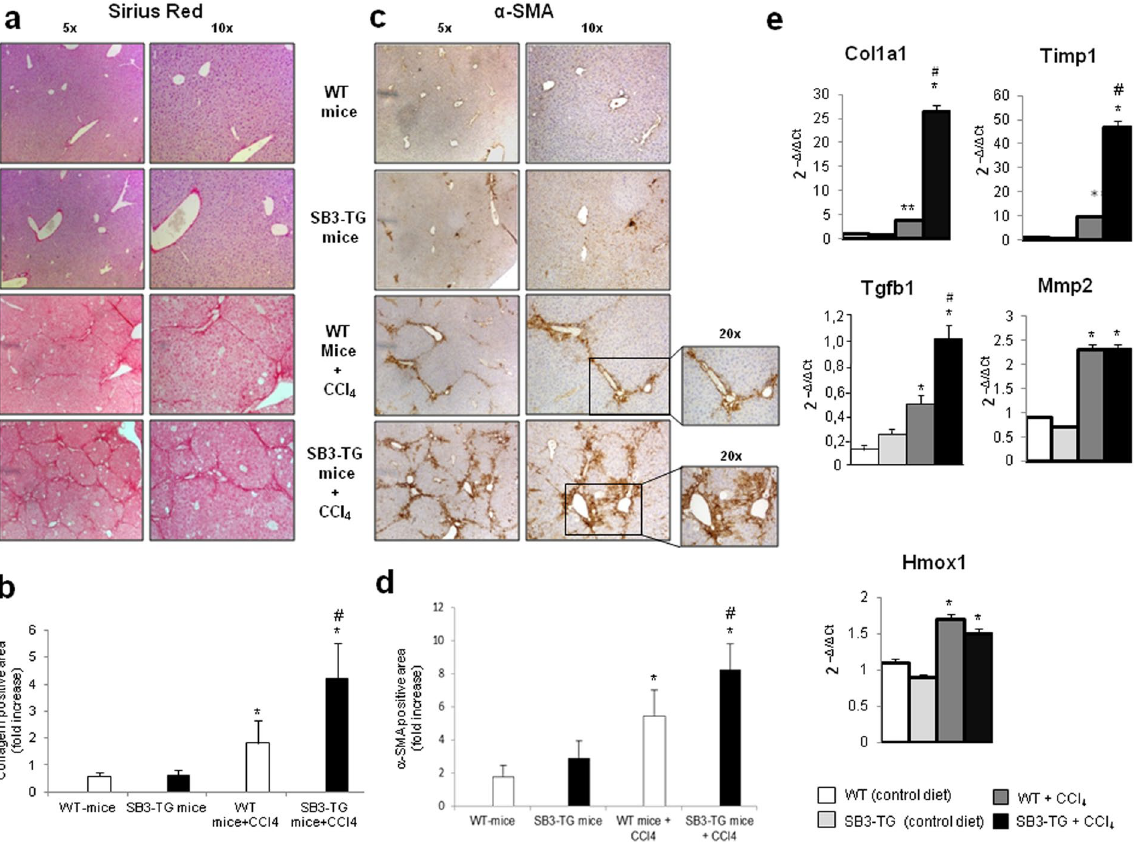
Figure 6. Liver fibrosis “ in vivo ” in SerpinB3 transgenic (TG) mice vs wild type (WT) mice exposed to chronic CCl 4 administration. (a,c) Following chronic exposure to CCl 4 (10 weeks) liver fibrosis was morphologically evaluated by Sirius red staining ( a ) or by immunohistochemistry for α -SMA ( c ). Original magnification as indicated. (b,d) ImageJ software analysis was performed for both Sirius red staining ( b ) and α -SMA immunohistochemistry analysis ( d ) to evaluate the amount of fibrosis. (e) Analysis by quantitative real-time PCR (Q-PCR) of SerpinB3 transcript levels of pro-fibrogenic genes in the different experimental groups. Data in graphs are expressed as means ± SEM (n = 6 mice for any experimental group) ( * p < 0.05 vs relative control mice; # p < 0.05 vs WT-mice treated with CCl 4